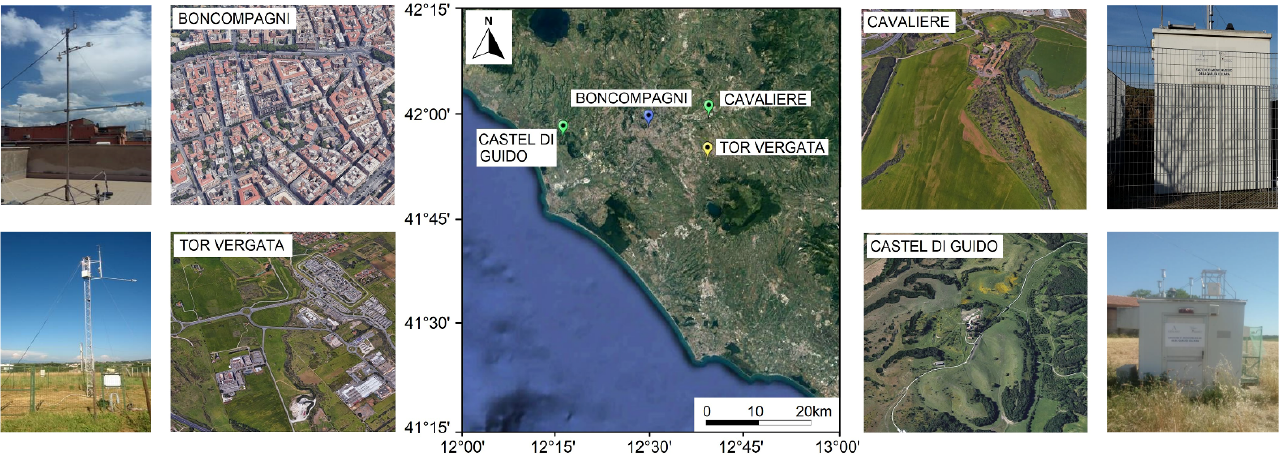
Figure 1. Map of the region of interest for this study with indication of the surface micrometeorological stations. The enlargements show the urban texture of the areas surrounding the stations.